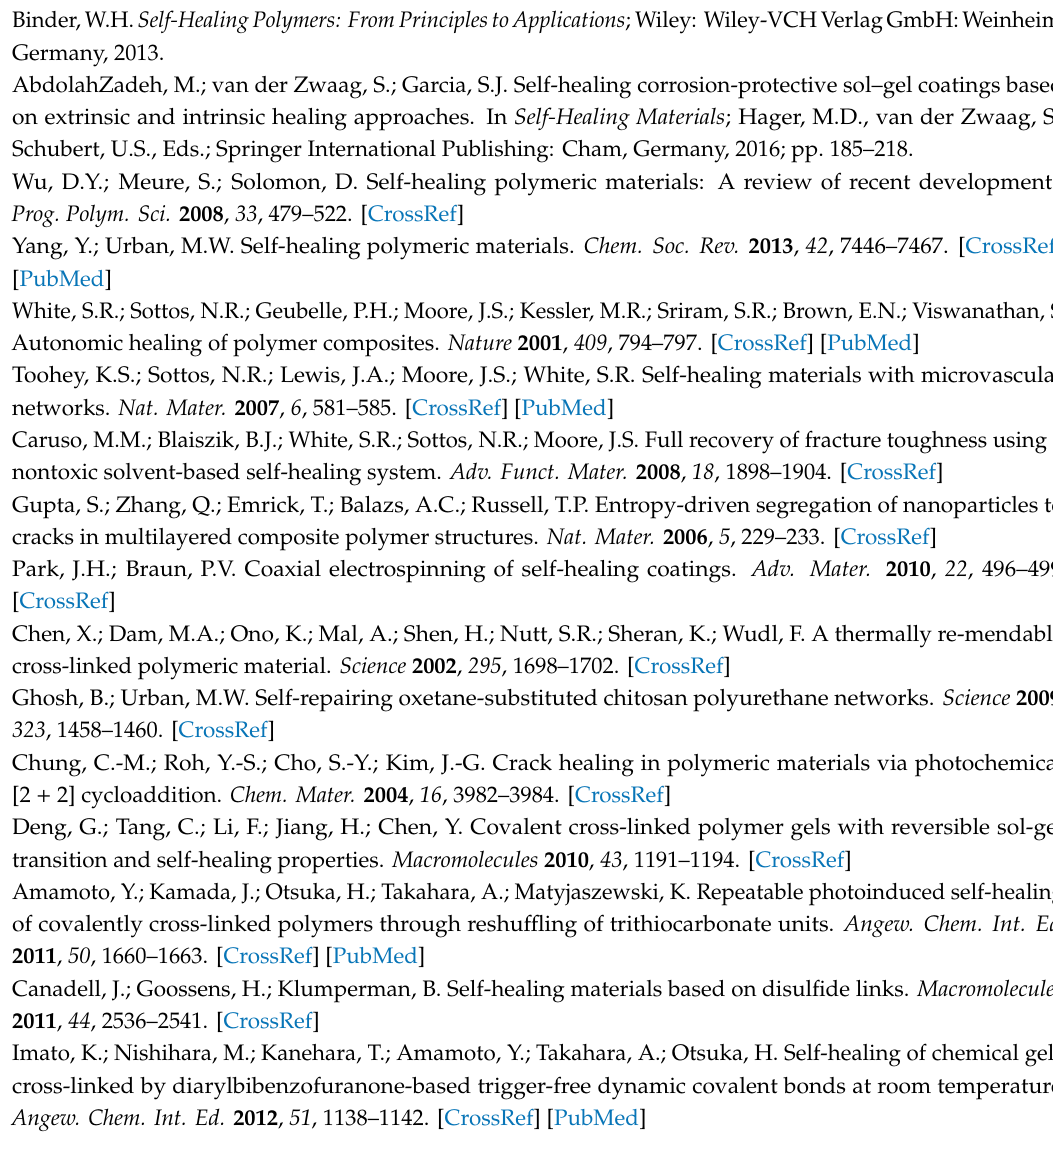
Figure S2: The optical photo of PDMS-COO-E, Figure S3: UV-vis spectra of PDMS-COO-E with thickness of 0.5 mm, Figure S4: FT-IR spectra of PDMS-COOH, PEGDGE and PDMS-COO-E., Figure S5: The dependence of sample mass of PDMS-COO-E on relative humidity for 10 days, Figure S6: Stress-relaxation of PDMS-COO-E at various temperatures, Figure S7: The shape memory property of PDMS-COO-E at 25 ◦ C, Figure S8: The